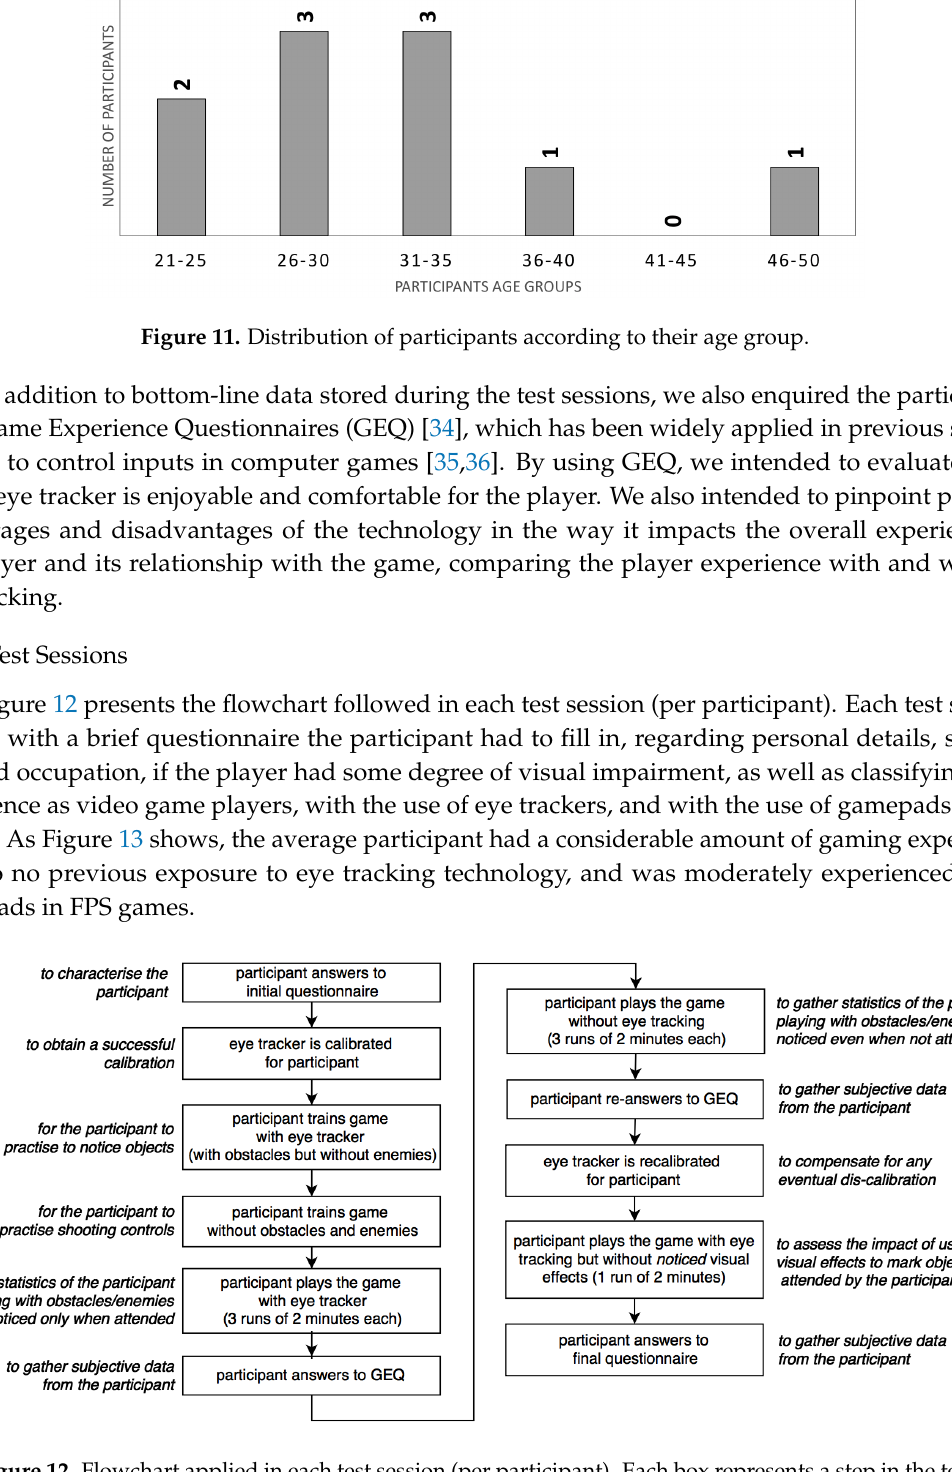
Figure 12. Flowchart applied in each test session (per participant). Each box represents a step in the test session and the accompanying off-box italicised text summarises the purpose of applying each